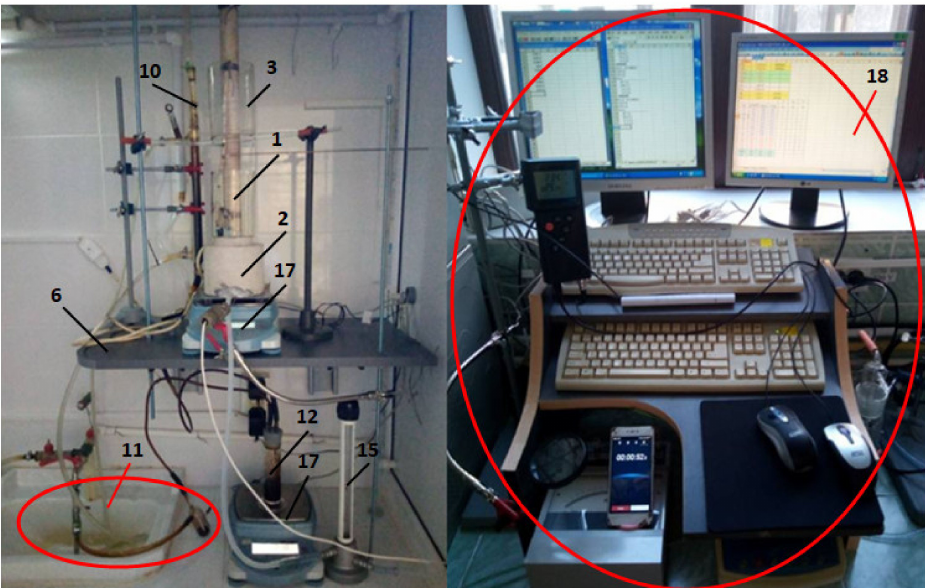
Figure 2. Experimental setup: (1) pyrolysis column; (2) autoclaved cellular concrete (ACC) support; (3) glass cylinder (jacket); (4) electric resistance; (5) autotransformer; (6) melamine board; (7) CO 2 tank; (8) CO 2 feed pipe; (9) pipe collecting volatile products; (10) Liebig condenser; (11) laboratory vacuum system; (12) oil collector; (13) pipe collecting non-condensable gases; (14) exhaust hood; (15) flow-meter; (16) thermocouples; (17) electronic balances; (18) data acquisition system; (19)